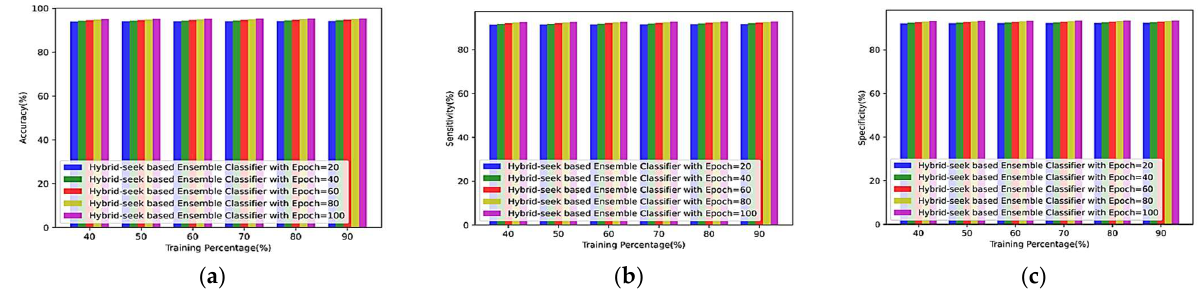
Figure A3. Analysis of performance using Siena database in terms of training % ( a ) accuracy, ( b ) sensitivity, and ( c ) specificity.